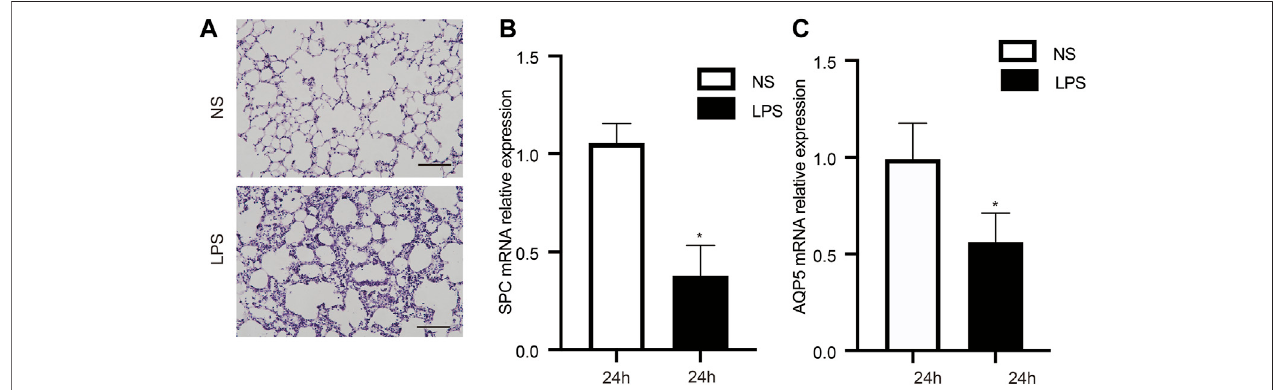
FIGURE1| CharacteristicsofanimalsintheLPS-triggeredandcontrolgroups. (A) PathologicalobservationsinlungtissuestainedwithH&E. (B,C) LPSdecreased the mRNA levels of SPC and AQP5. n (cid:1) 12/group; * p < 0.05; ** p < 0.01. LPS, lipopolysaccharide; NS, no lipopolysaccharide; SPC, surfactant protein C; AQP5, aquaporin 5; Scale bar: 40